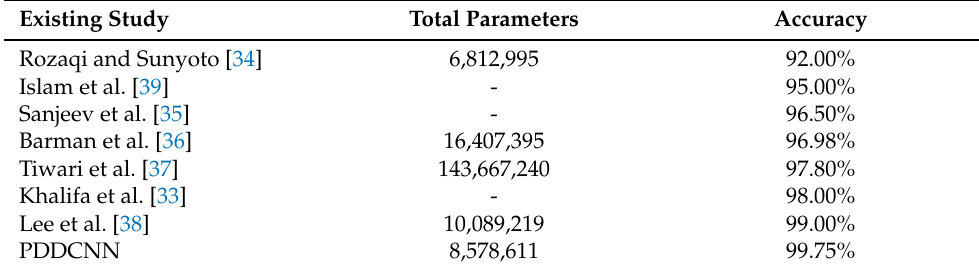
Table 11. Comparison with existing